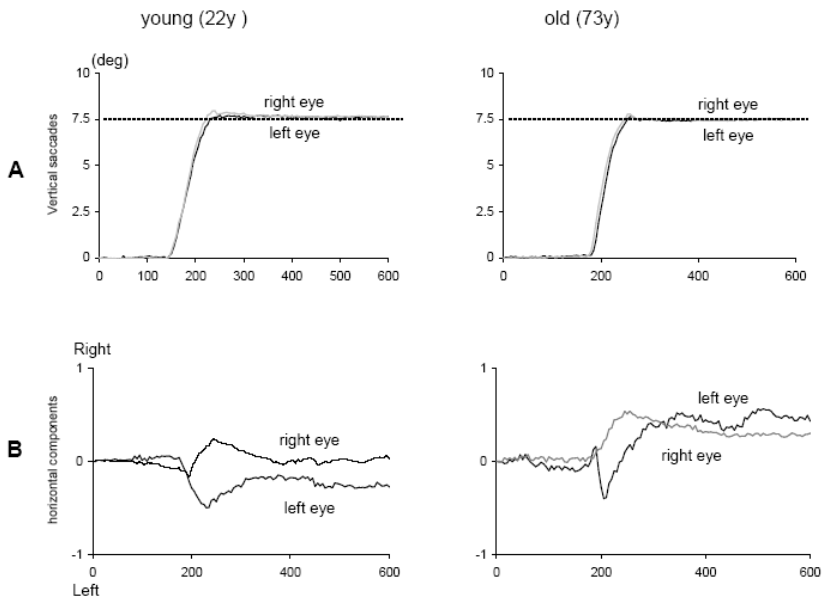
Figure 10. Examples of upward saccades from one young and one elderly participant: (A) vertical saccades for left eye and right eye, horizontal dotted line indicate target position; (B) horizontal components during upward saccades